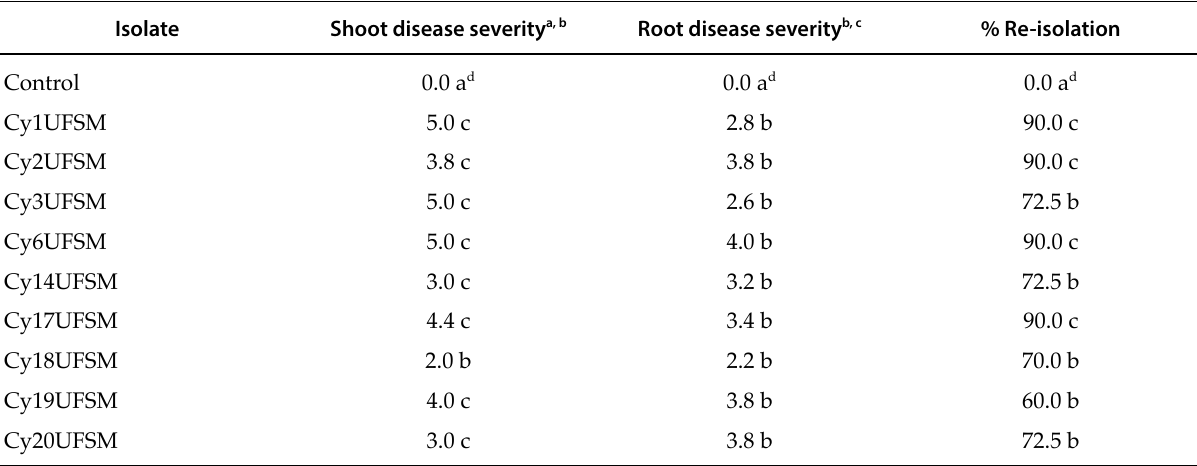
Table 3. Mean shoot and root severity scores, and re-isolations percentages, for different Campylocarpon pseudofasciculare isolates inoculated on to Vitis labrusca cv. Bordô, after 4 months incubation in a greenhouse. Isolate Shoot disease severity a,